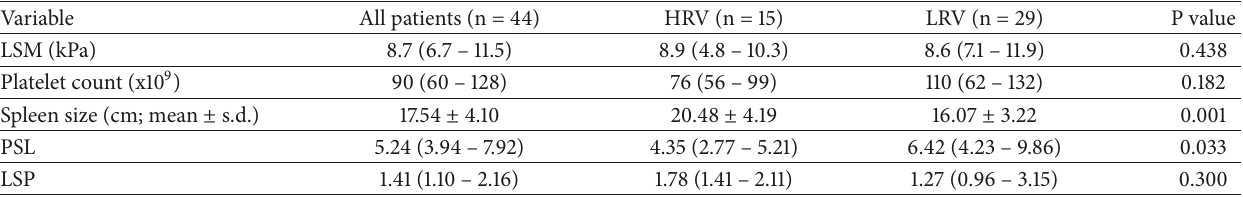
Table 2: Association of liver stiffness and clinical parameters of portal hypertension with presence of HRV at gastroscopy. HRV, high risk varices; LRV, low risk varices; LSM, liver stiffness measurement; PSL, platelet count to spleen length; LSP, liver stiffness-spleen length to platelet count ratio score. Values are median (IQR), unless stated otherwise.